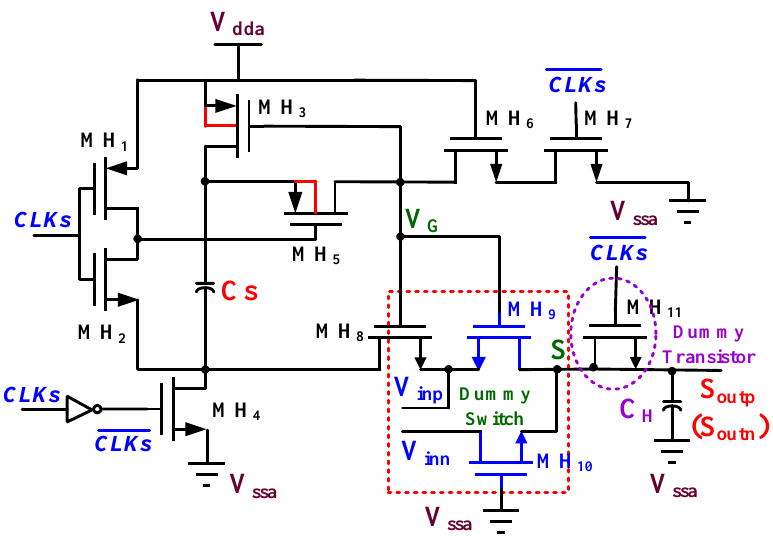
Figure 7. Modified sample-and-hold circuit with modified bootstrapped switch, including a dummy switch and a dummy transistor.